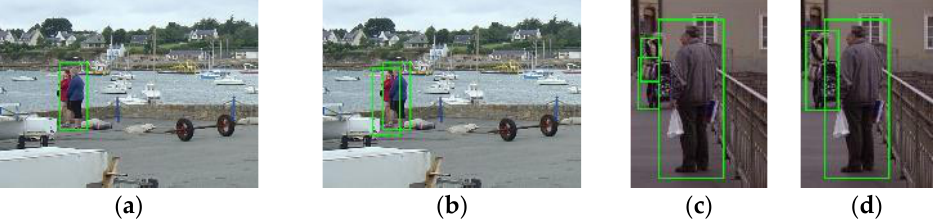
Figure 25. By removing the O-Net from the integrated detector, more human bodies ( 𝑓 𝑠𝑠 = 20 , 𝑠 𝑡ℎ𝑟 = 16 ) were detected ( b , d ) than with the complete integrated detector ( a , c ).